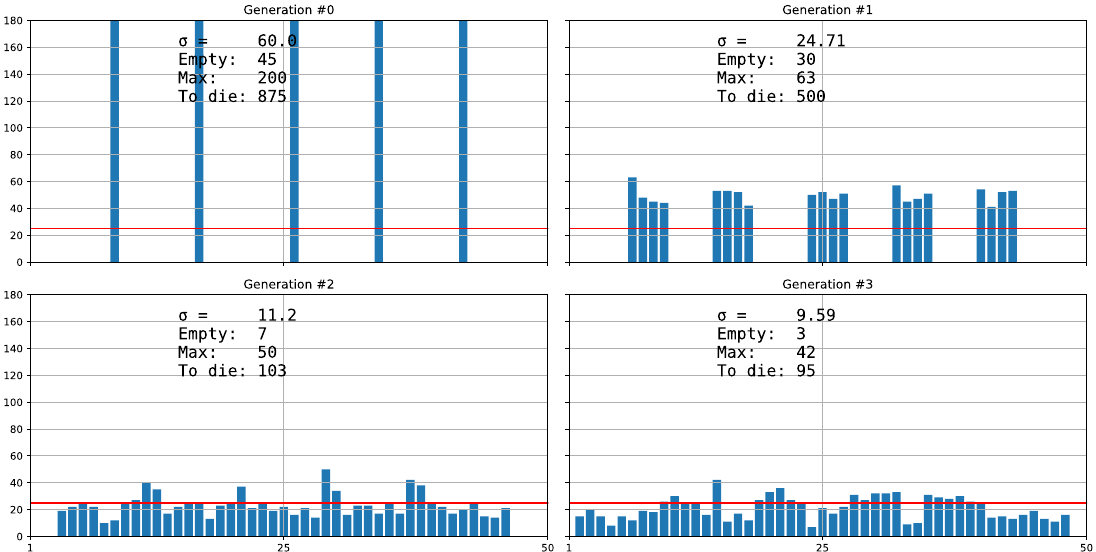
Figure 1. Strategy n . The Y -axis represents the species population, and the X -axis the 50 cells ( nCells in the figure). In the first chart or Generation #0, the 1000 organisms distribute themselves among five equidistant cells out of the 50 that are available. The following charts depict how in the next generations, organisms distribute themselves randomly within their neighboring cells, one by one, under the distribution 6n , which equates to distribution among the three adjacent cells on both sides of the cell of origin. Observe that the greater the iteration of generations, the greater the uniformity of distribution, the lesser the variance ( 𝜎 in the figure), the lesser the population density in the most populated cell (Max in the figure) and the greater the number of organisms that die because they cannot access the limited resources ( To die in the figure). In this example, the carrying capacity is k = 25 (red line in the figure), meaning 25 organisms can survive in each cell.